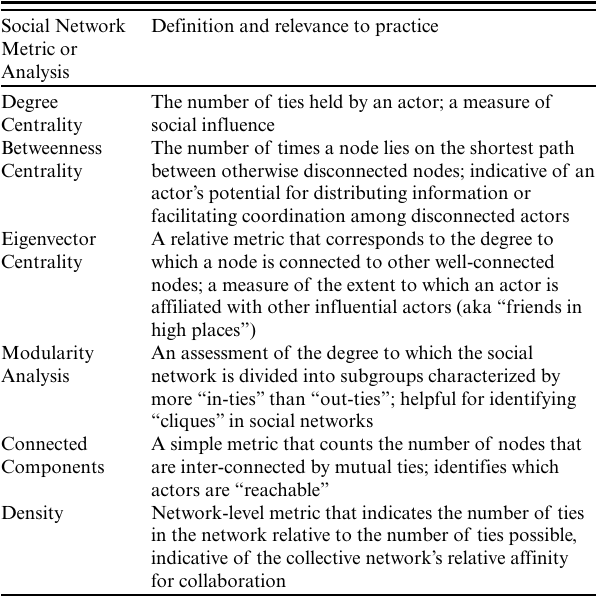
Table 3 . Definitions of common social network analysis metrics